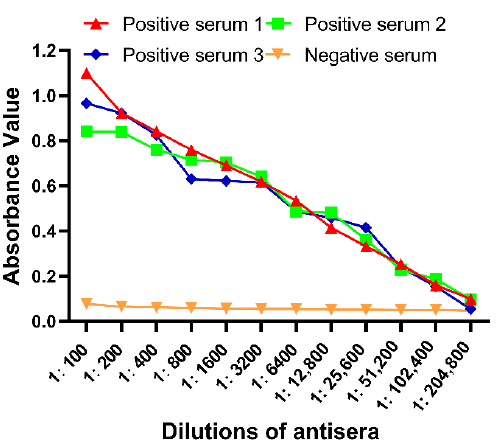
Figure 3. The absorbance of negative and positive serum with different dilutions was determined by ELISA. The ratio of the positive serum and the negative serum is greater than 2.1 and the titer of the antibody is the dilution factor of the antibody. X-axis: different dilution ratios of anti-RIPK3 serum using multiple dilution methods. Y-axis: the value of anti-RIPK3 serum at 450 nm wavelength. Red, green, and blue represent positive serum (serum obtained from rabbits after immunization) and orange represents negative serum (serum obtained from rabbits before immunization).